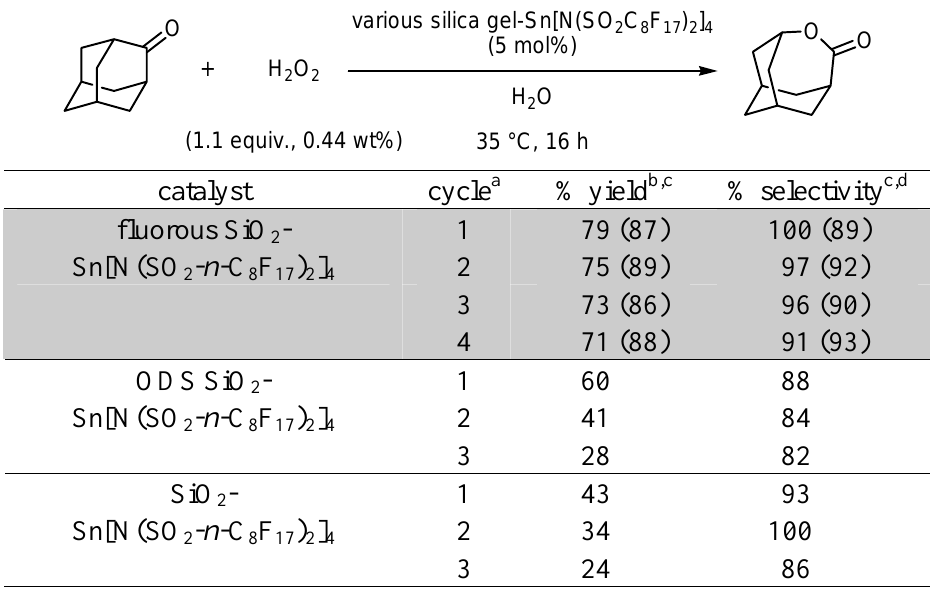
Table 5. Baeyer − Villiger reactions catalyzed by silica gel-supported Sn[N(SO